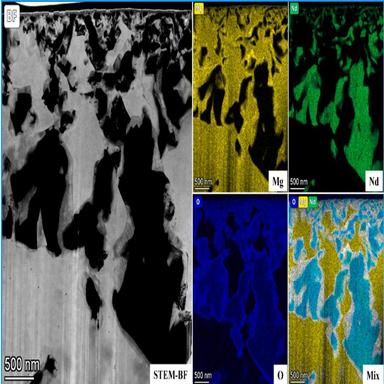
(a) STEM-BF image and corresponding EDS elemental distribution maps of the region occupied by Mg12Nd precipitate after oxidation for 100 h; (b) STEM-BF image and corresponding EDS elemental distribution maps of the region free of Mg12Nd precipitate after oxidation for 100 h; (c) EDS line-scan 3 showing the elemental distribution across the duplex surface oxide scale and the underneath internal oxide precipitate in (b); (d) enlarged STEM-BF image and corresponding EDS elemental distribution maps of Region B